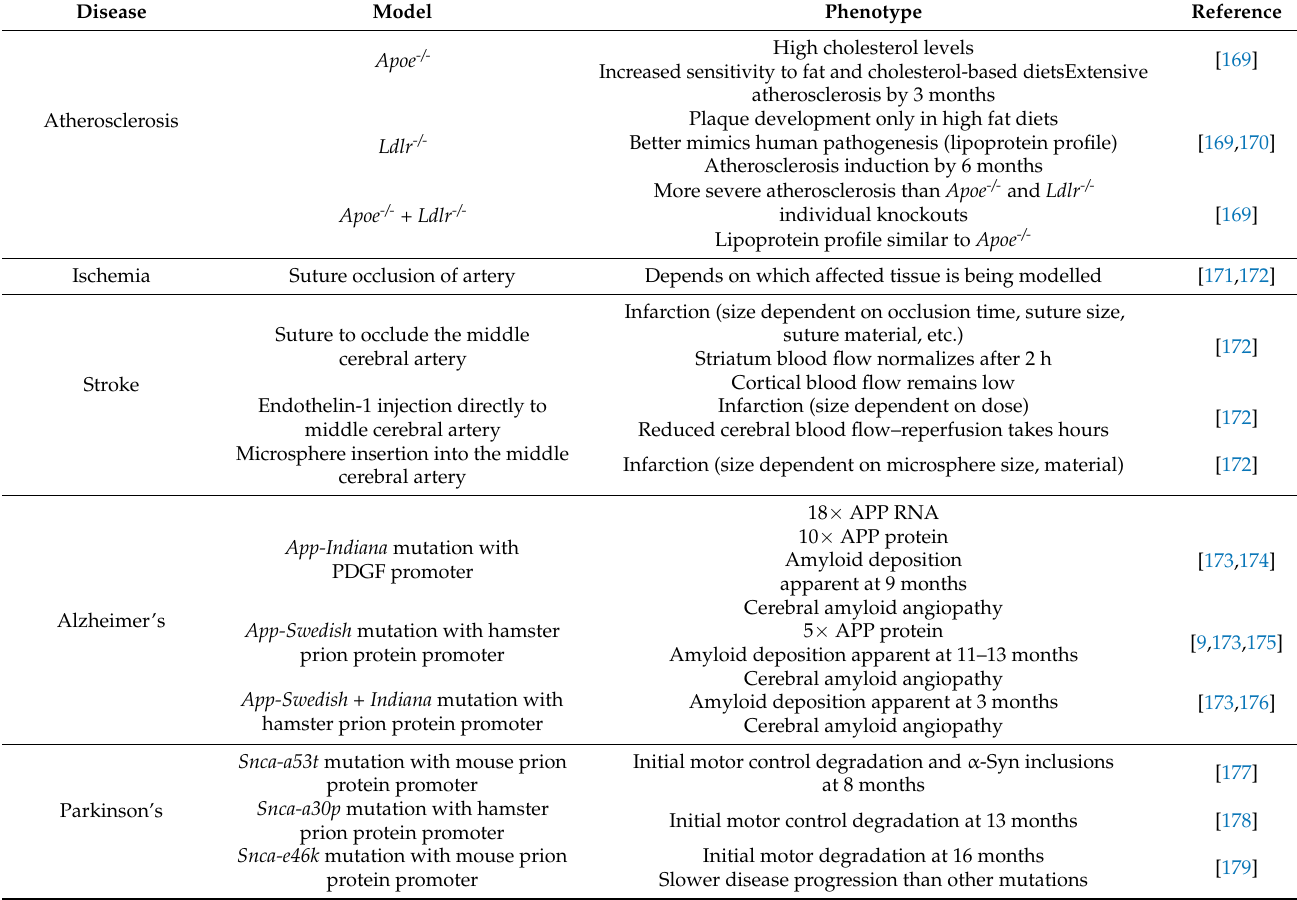
Table 1. Some commonly used mouse models for cardiovascular diseases and neurodegenerative diseases. Diseases included are: Atherosclerosis, Ischemia, Stroke, Alzheimer’s Disease and Parkinson’s Disease. Disease Model Phenotype Reference